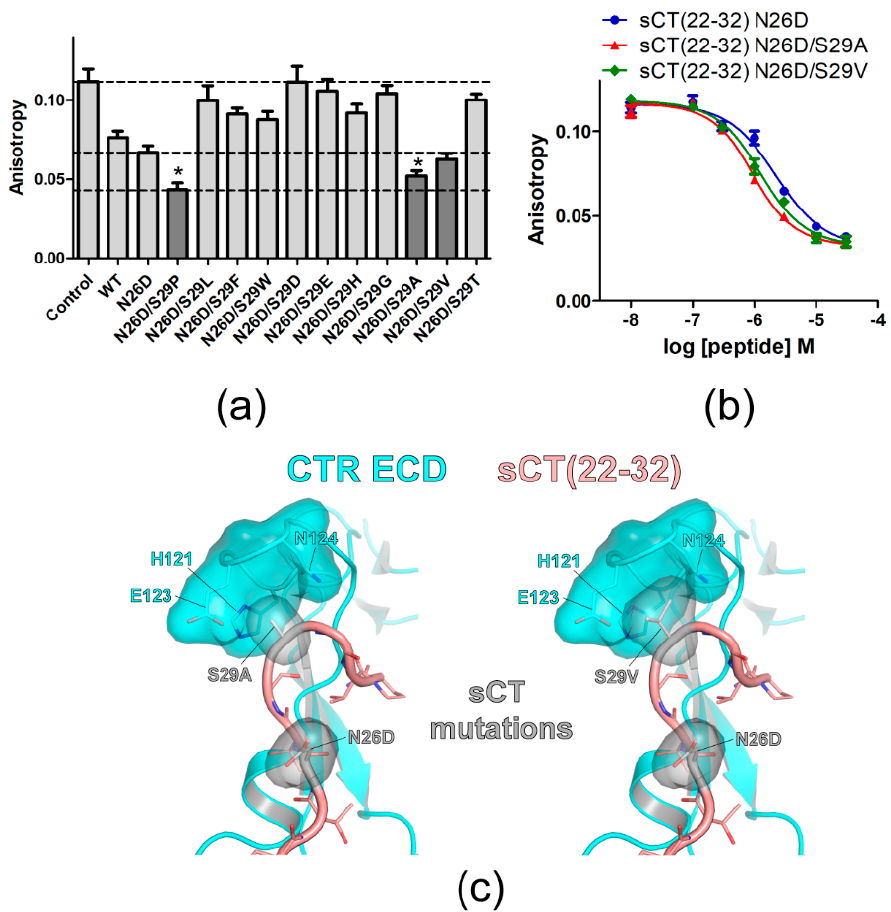
Figure 2. Mutational effects of sCT S29 residue on sCT(22–32) affinity. ( a ) FP competition peptide binding assay with 3 µ M peptide analogs with mutations at S29. The mutations showing lower anisotropy values than that of sCT(22–32) N26D backbone peptide were indicated in dark gray. For comparison, anisotropy values of Control, sCT(22–32) with N26D mutation and sCT(22–32) with N26D/S29P mutations were indicated with dotted lines. Two technical replicates were used for each experiment. Anisotropy values from three independent experiments (each experiment has two technical replicates of anisotropy values for each peptide) were combined and the average anisotropy was shown with S.D. as error bars. Asterisk (*) indicates anisotropy decreases with a statistical significance ( p < 0.05) compared to sCT(22–32) N26D. ANOVA with Dunnett’s post hoc test was performed with PRISM. sCT(22–32) N26D was used as a control group for the post hoc test. ( b ) FP competition peptide binding assay with sCT(22–32) N26D/S29A and N26D/S29V mutations. FITC-